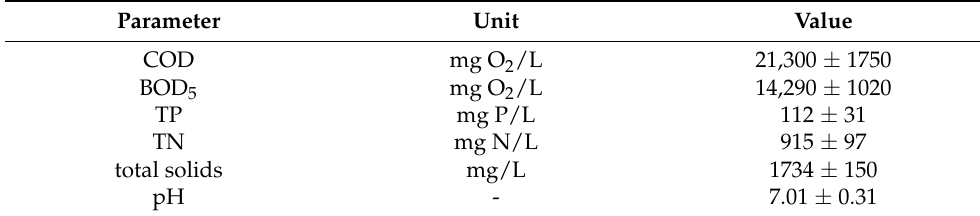
Table 1. Characteristics of dairy wastewater used in this study.